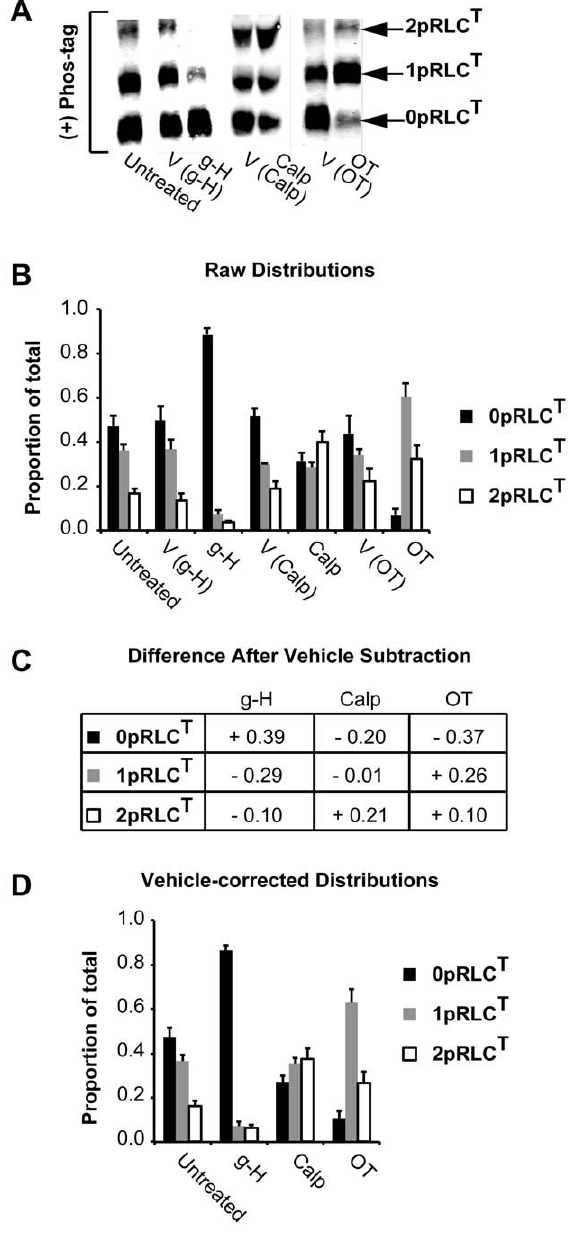
Figure 3. Quantification of RLC phospho-state distribution. Panels A-D correspond to WB data derived using an Ab directed toward the C-terminus of RLC. A. Representative WBs demonstrating RLC phospho-states separated by Mn 2 + -phos-tag SDS-PAGE. Uterine myo- cytes were lysed and total protein was harvested after the following treatments: untreated, or treated with g-H, Calp, OT, or with their corresponding vehicles. B. Quantification of bands identified in panel A (untreated; n=12, g-H; n=5, Calp; n=8, OT; n=7). The signals derived from 0pRLC T , 1pRLC T , and 2pRLC T are expressed as the proportion of their sum total within each lane. C. Absolute magnitude of the difference in each phospho-state caused by the treatments in comparison to the corresponding vehicle (‘ + ’ indicates enhancement relative to vehicle, ‘ 2 ’ indicates diminution relative to vehicle). D. Vehicle-corrected distribution data obtained by combining the data in panel C to the untreated group distribution. g-H (glycyl-H-1152); ROK inhibitor (1 m M). Calp (calpeptin); rhoA activator (0.5 mU/mL). OT; oxytocin (100 nM). All data are shown as means 6 SEMs. The corresponding numerical data are compiled in Table 1.